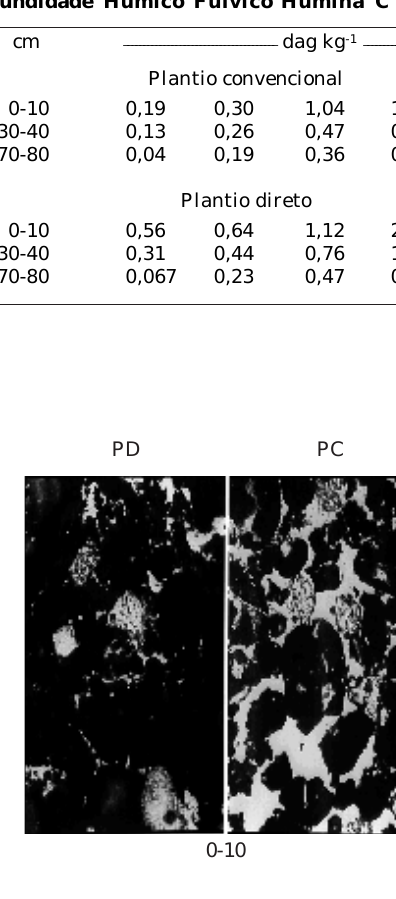
Figura 1. Seções finas de um Latossolo Roxo em diferentes profundidades (plantio direto PD e plantio convencional